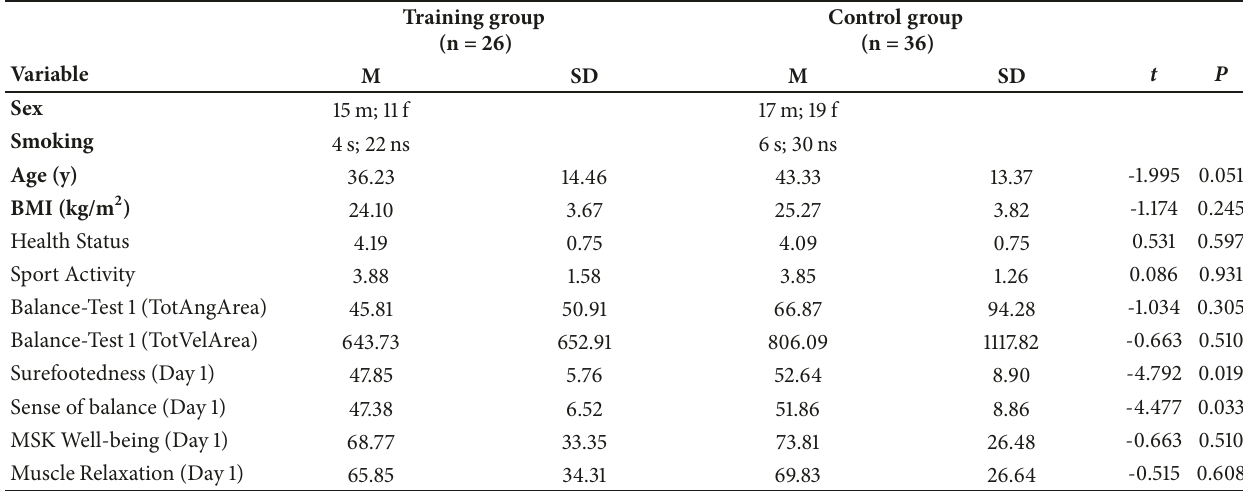
Table 1: Descriptive and inferential statistics of study variables at baseline.